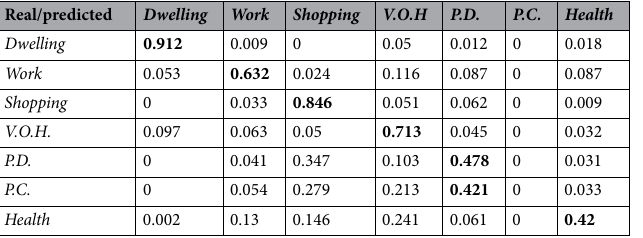
Table 3. Confusion matrix of activity type identification on the test dataset with Gstp2Vec framework. V.O.H. Visiting Others’ Home, P.D. Public Drink, P.C. Public Community. Maximum ratios of predicted types for each ground truth activity label are in